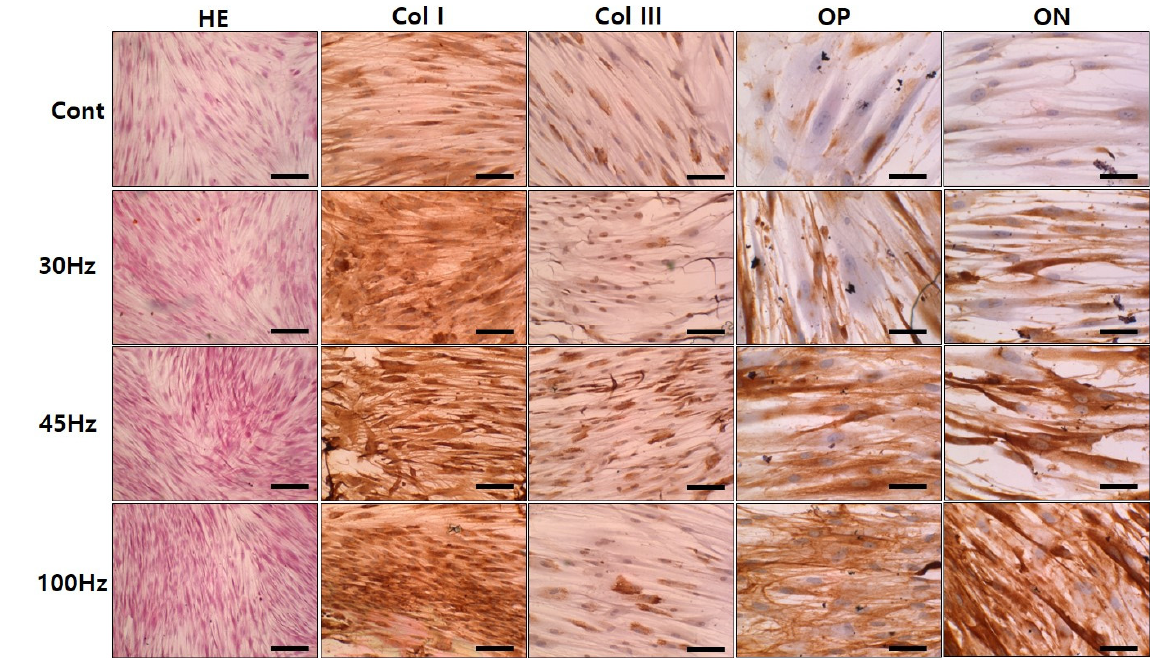
Figure 6. Immunohistochemical staining of human dental pulp stem cells subjected to 14 d of mechanical vibrations. Collagen type I was strongly detected at 45 Hz and 100 Hz, and collagen type III was strongly detected at 45 Hz. Additionally, osteopontin (OP) and osteonectin (ON) were strongly detected at 45 Hz and 100 Hz. HE: Hematoxylin-eosin staining. Original magnification; HE: 100×, Col I and Col III: 200×, OP and ON: 400×, Scale bar; HE: 200 μ m, Col I and Col III: 100 μ m, OP and ON: 50 μ m.